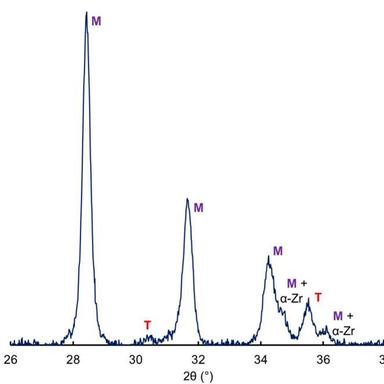
XRD scan of uncoated sample quenched at 1000 ◦C, with monoclinic (M) and tetragonal (T) peaks indicated.